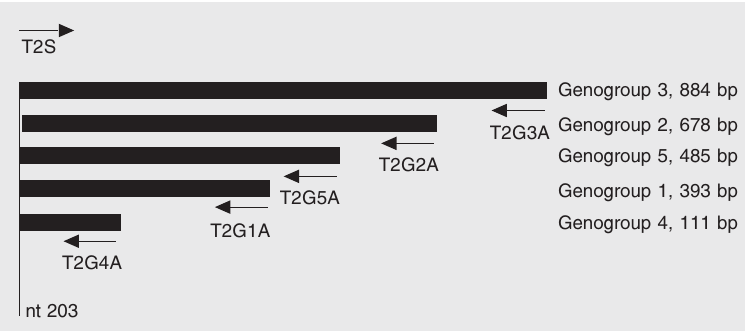
Figure 1. Localization of the oligonucleotides used for multiplex PCR on the Torque teno virus (TTV) genome and size of the products generated. ‘nt 203’ refers to the position of the 5' end of the ‘universal’ sense primer T2S (numbering according to TTV prototype TA278, Genbank accession number